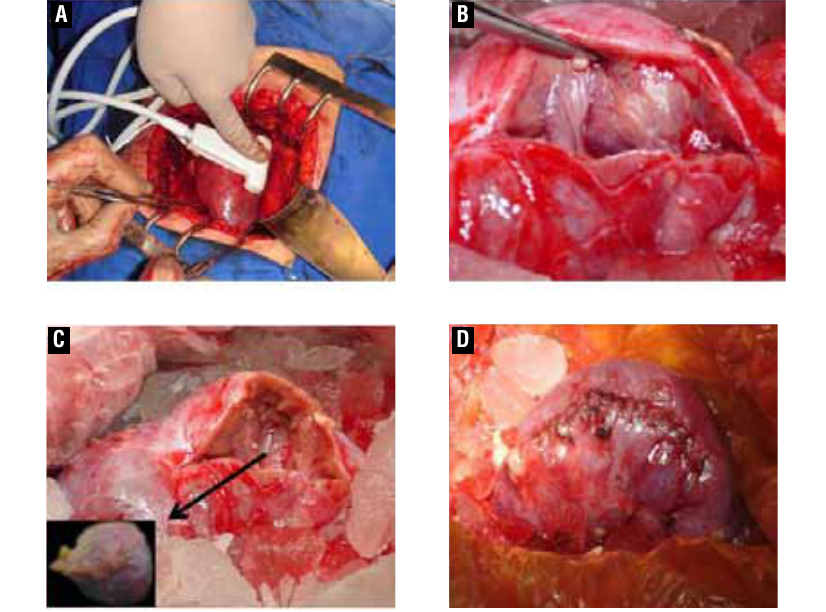
figure 2 - (A) Identification of the tumor using ultrasound; (B) Brodel’s vascular line incision and tumor identification; (c) Image after enucleation of the tumor ; (D) Renorrhaphy.